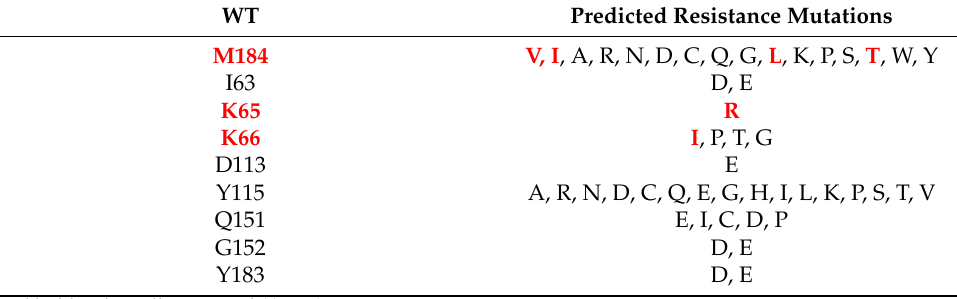
Table 1. List of predicted resistance mutations in HIV-RT for (-)-FTC.